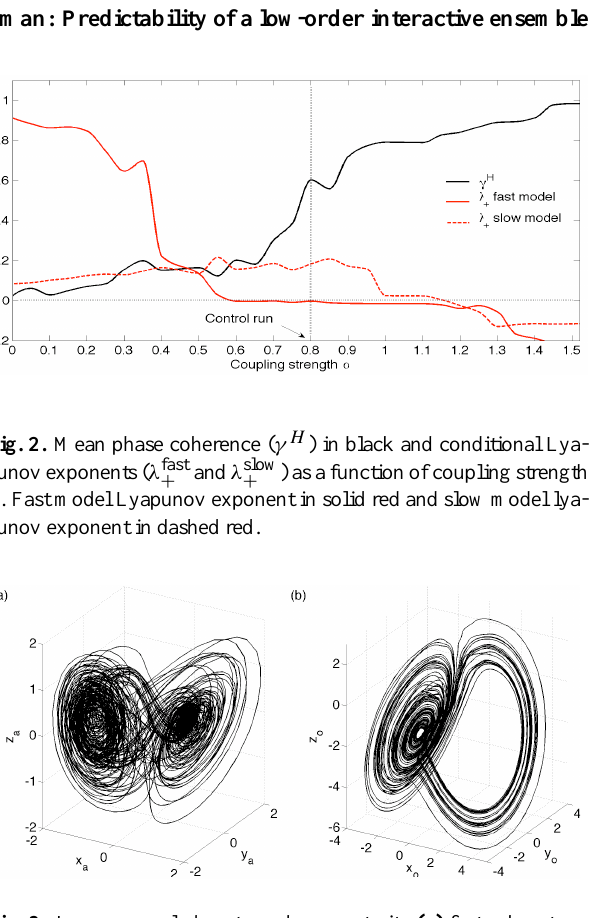
Fig. 3. Lorenz coupled system phase portrait. (a) fast subsystem; (b) slow